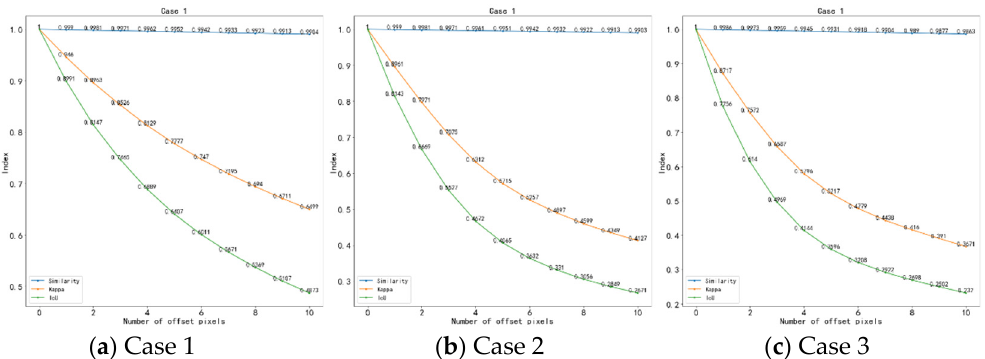
Figure 11. Line charts of three indicators changes with pixel offset.